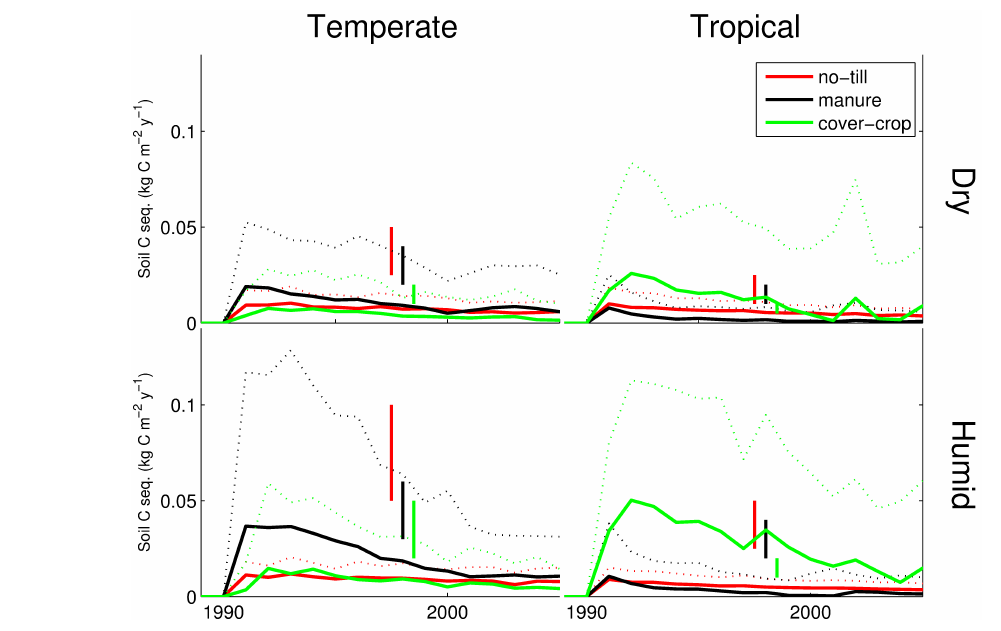
Figure 2. Simulated mean C sequestration following the implementation of management over the CRU historic period on agricultural soils averaged (thick lines) for the selected grid cells in the four climatic regions, compared to estimates (vertical lines) from Stockmann et al. (2013). Dotted lines indicate the mean plus 2SD (standard deviations) from all grid cells in each climatic region. The vertical lines do not represent specific years but the potential over time to sequester C on cropland soils.